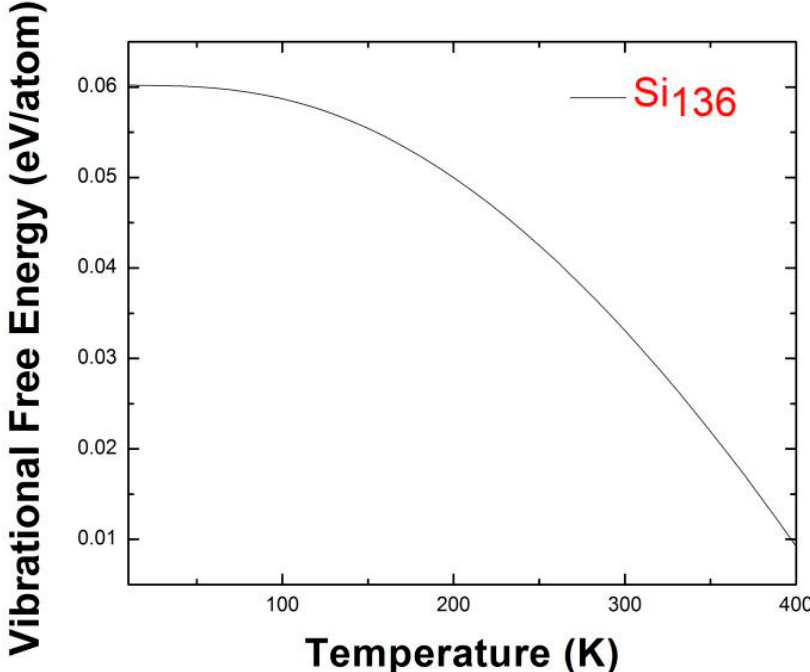
Figure 9. Predicted vibrational free energy including zero-point contribution for Si 136 , in the range of 10–400